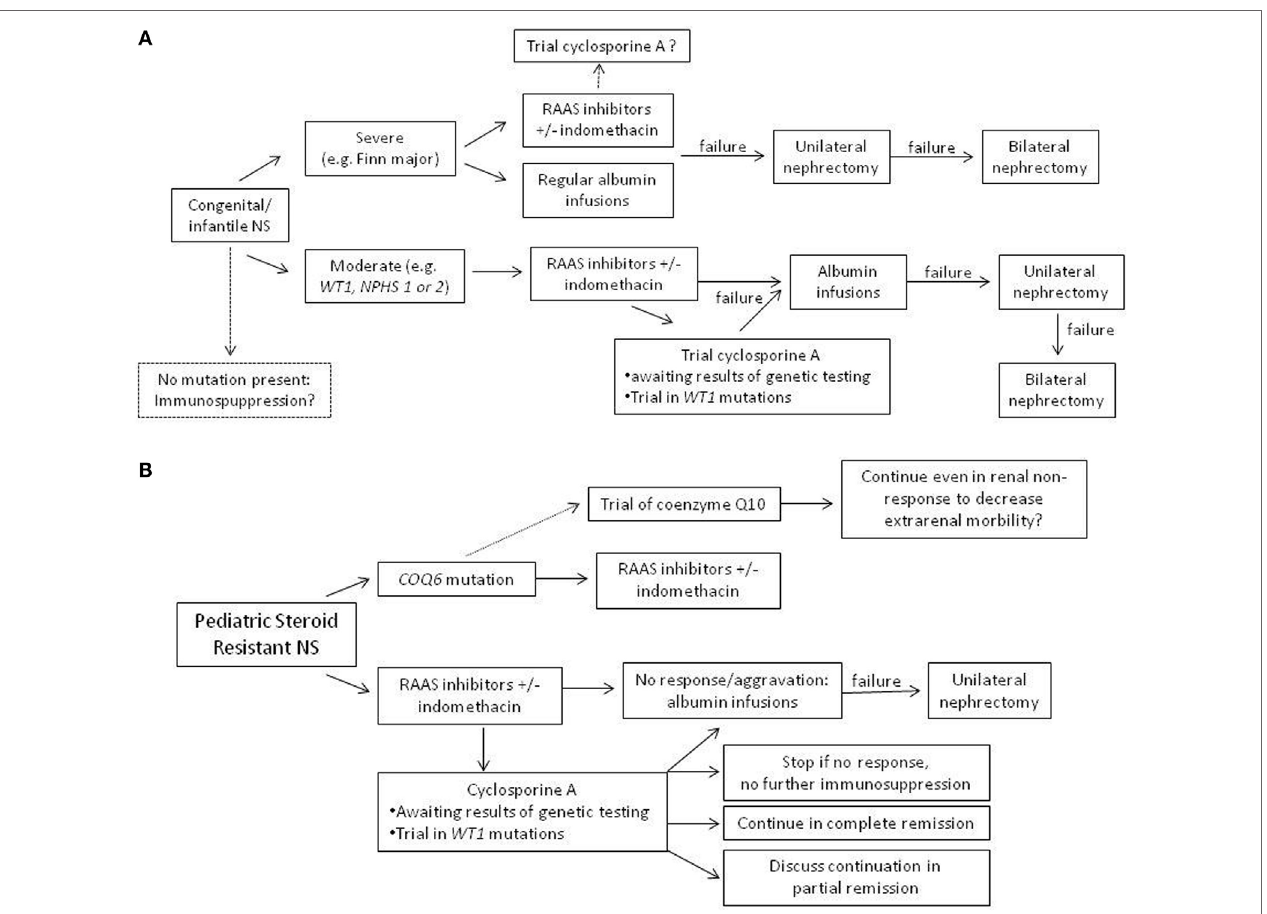
FiGURe 2 | Suggestion of an algorithm for treatment in genetic nephrotic syndrome (NS). (A) Congenital and infantile NS with positive testing results. (B) Pediatric steroid-resistant nephrotic syndrome, where often, results of genetic testing are not available